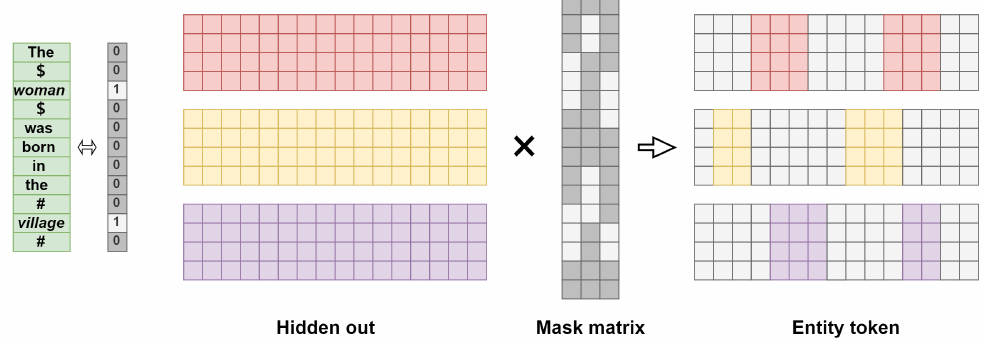
Figure 3. The mask matrix is automatically generated by reading the entity markers, and the mask matrix is multiplied with the hidden layer output vector to extract the entity’s corresponding feature